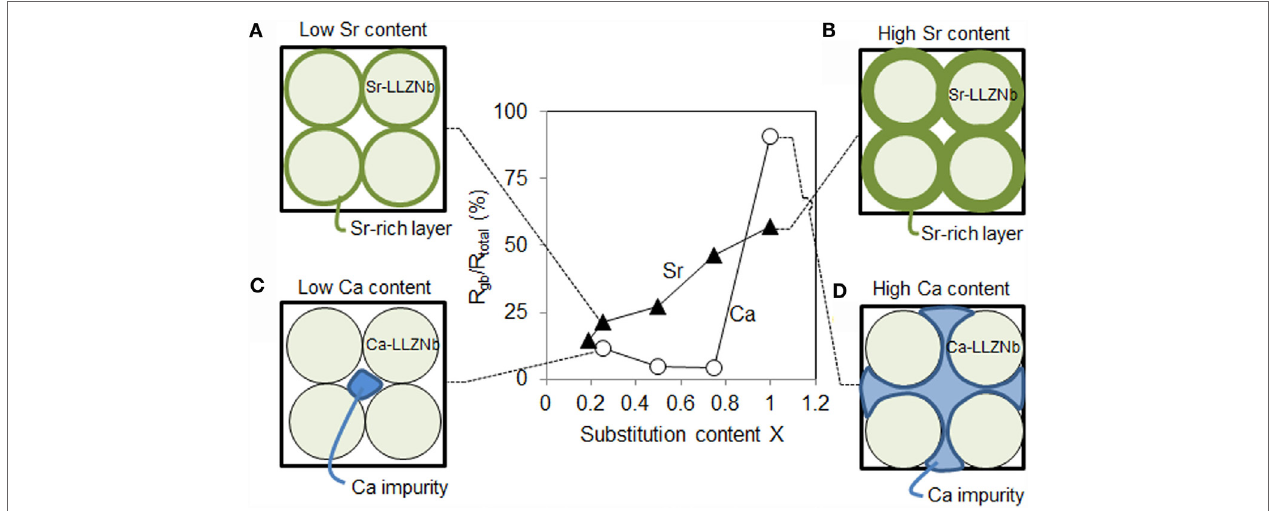
FigUre 4 | schematic images of the grains and grain boundaries of (a) low sr and (B) high sr-substituted llZnb, and (c) low ca and (B) high ca-substituted llZnb . (D) R gb /R total ratios as functions of X .